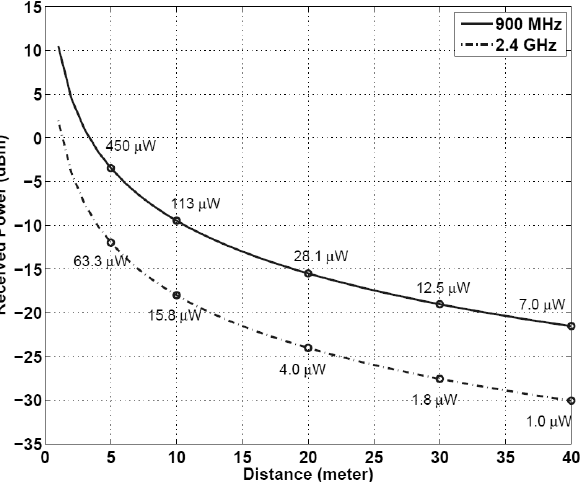
Figure 2. The impact of distance on the received power in RF power